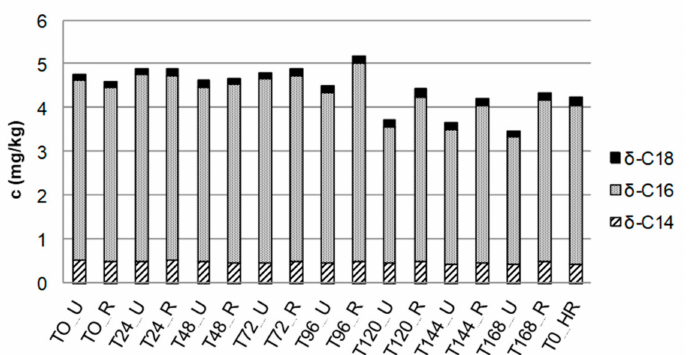
Figure 6. Concentrations of δ -tetra- ( δ -C14), δ -hexa- ( δ -C16), and δ -octadecalactone ( δ -C18) in cocoa liquor of different fermentation times, unroasted (U)/roasted (R)/high roasted (HR), after removal of triglycerides. Concentrations determined by means of LC–MS/MS (SD <